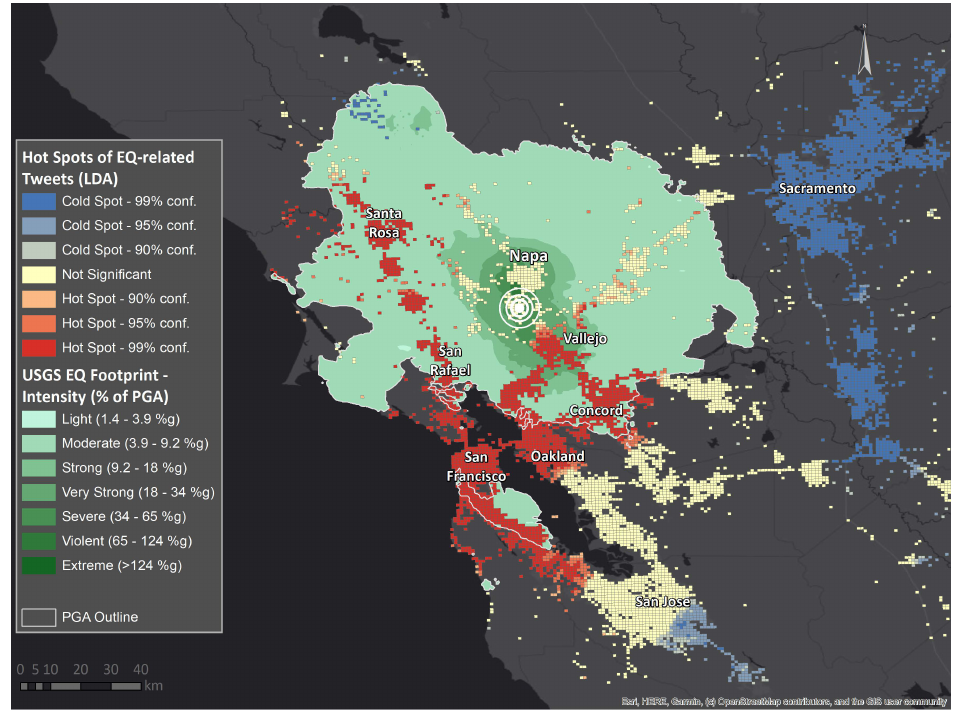
Figure 6. Earthquake hot and cold spots obtained using plain LDA compared to the US